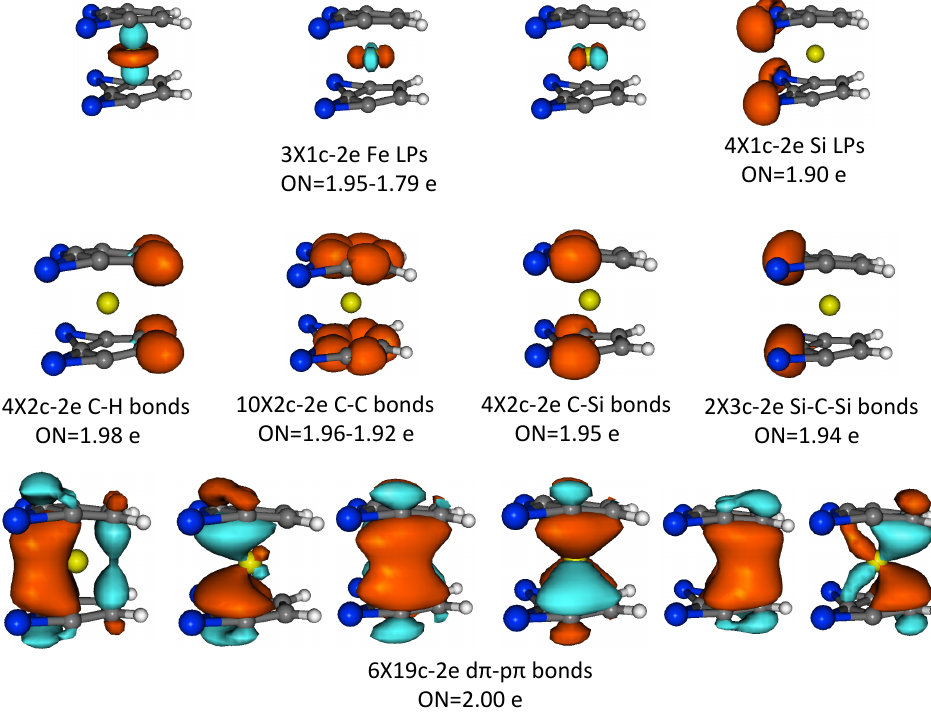
5 -C 2 + ( 1 ) as obtained from AdNDP 2 - η 5 H 2 ) 2 ]